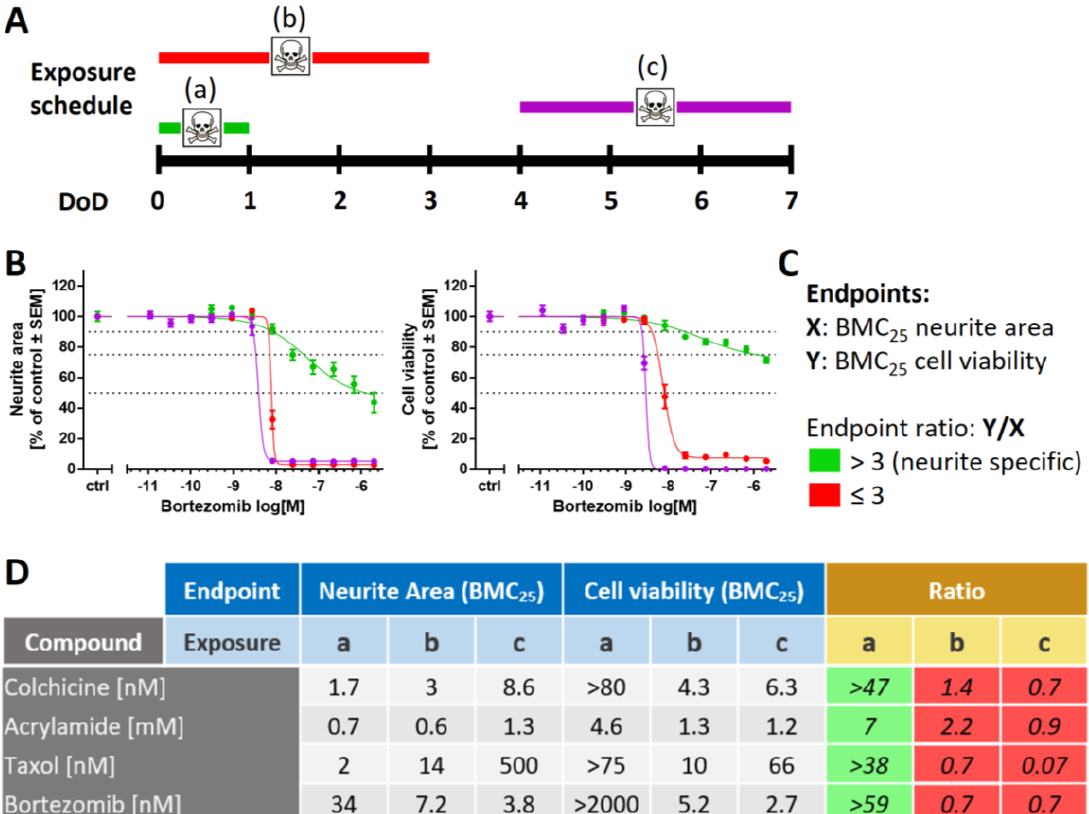
and F-actin (red) and on DoD7 (middle, right) for the sensory neuronal transcription factors BRN3A or ISL1 (green) and the cytoskeletal proteins β IIITub or peripherin (PRPH) (red). Color codes and scale bars are given in the images, and the details are shown in Figure S1. DoDx—day of differen- tiation, counting from thawing of frozen neural precursors on DoD0. ( B , C ) Whole transcriptome analysis (19,000 genes) was performed for early differentiation states (DoD1, 4, and 7) of SBAD2- and Si28-derived neurons. Data are derived from three independent differentiations (full data in Supplementary File S1). ( B ) The heatmap depicts the row-wise Z-scores of the top 50 regulated genes (exhibiting the highest variance across all samples). The upper group, as defined by the clustering algorithm, mainly consists of genes upregulated (red) during differentiation and the lower group mainly consists of genes downregulated (blue). ( C ) For the top 500 variable genes of this data set, a principal component analysis (PCA) was performed. In the two-dimensional PCA display, three differentiation stages are color-coded according to their DoD. Data points and heatmap columns correspond to all technical replicates measured in the 3 experiments per cell line. ( D ) Peripheral neurons derived from the iPSC lines mciPS (orange), SBAD2 (green) and Si28 (blue) were used in the PeriTox test. The peripheral neurotoxicants taxol, bortezomib, colchicine, and acrylamide were used as positive controls. Effects on the neurite area (solid symbols and lines) and the cell viability (open symbols, dashed lines) are shown. Data are expressed as the mean ± SD of three biological replicates.